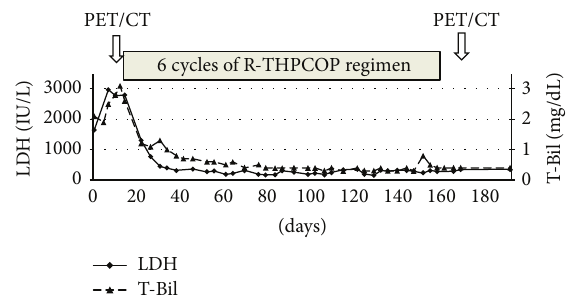
Figure 3: Clinical course of the patient. The 𝑥 -axis presents time (days) from admission to our hospital. LDH: lactate dehydrogenase; T-Bil: total bilirubin; and PET/CT: positron emission tomogra- phy/computed